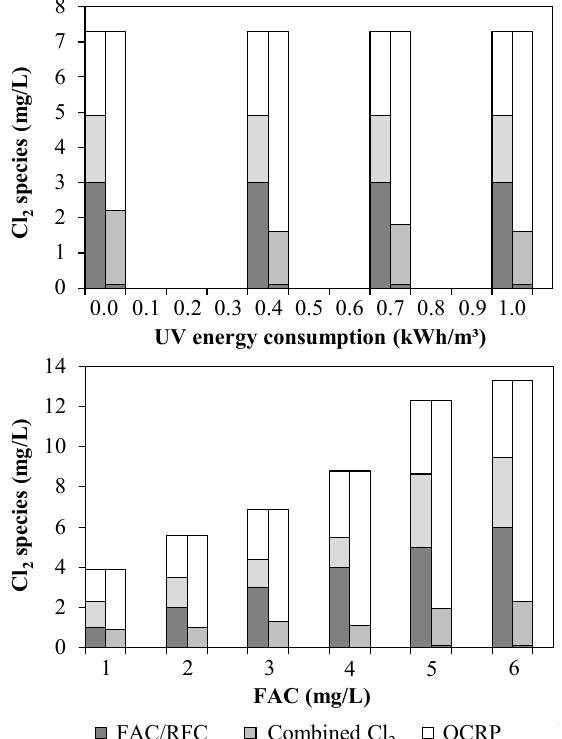
Figure 3. Chlorine species in UV chamber influent (1 m 3 /h WWTE) (left columns) and in effluent of the pilot plant after UV treatment and subsequent quenching with H 2 O 2 (right columns): ( Top ) Experiment 1 (0–1 kW, 3 mg/L FAC in UV chamber influent); and ( Bottom ) Experiment 2 (0.4 kW, 1–6 mg/L FAC in UV chamber influent).